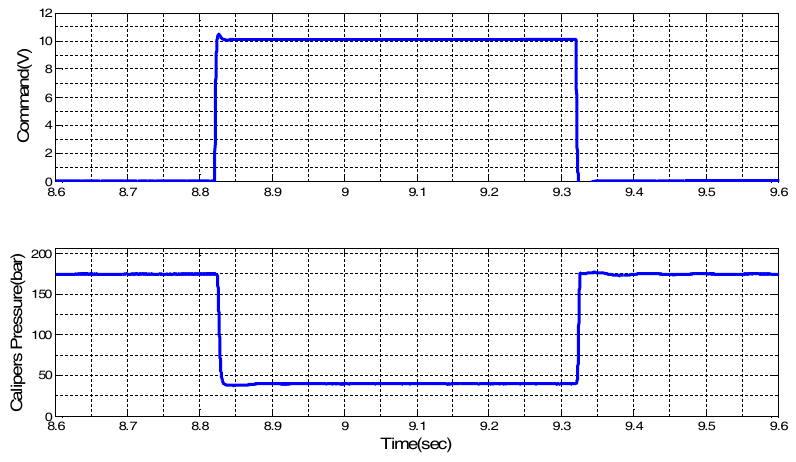
Figure 22. Step wave command at proportional valve relief test in 175 bars (timing sequence from 8.6 s to 9.6 s).